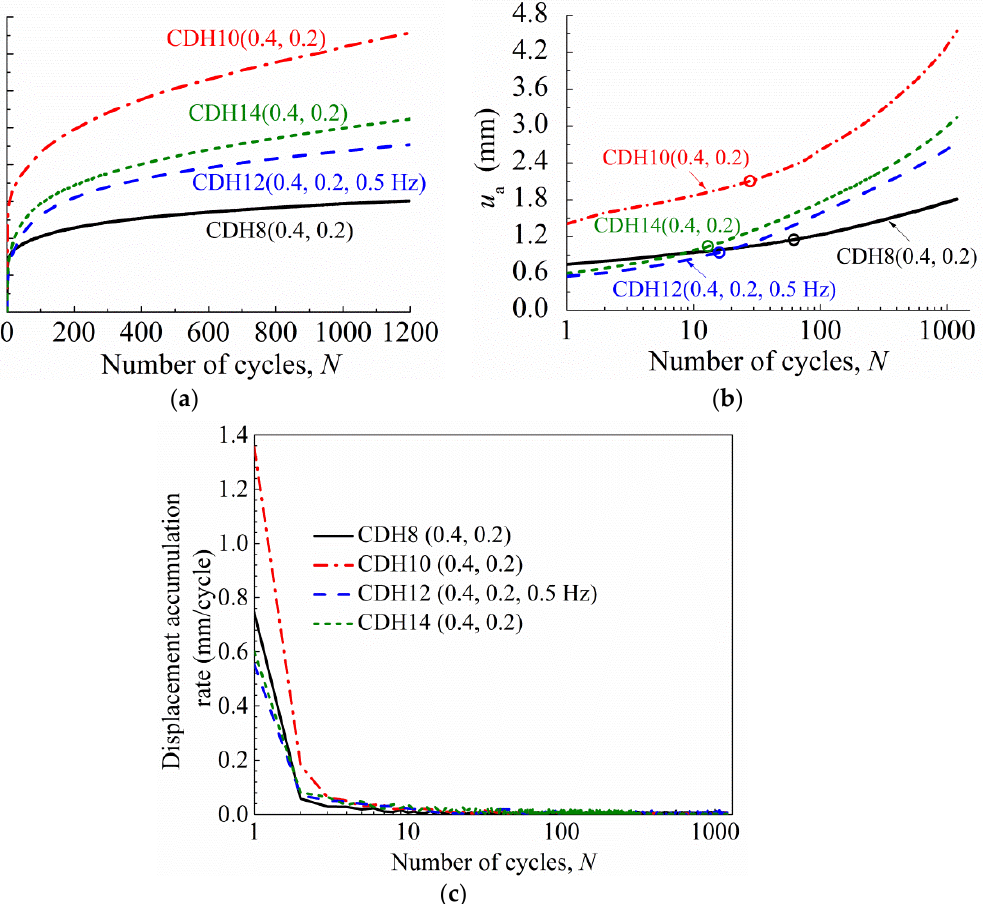
Figure 7. Developments of accumulated displacement and displacement accumulation rate at dif- ferent embedment ratios: ( a ) linear scale of u a - N; ( b ) semi-log scale of u a - N; ( c ) semi-log scale of ferent embedment ratios: ( a ) linear scale of u a - N ; ( b ) semi-log scale of u a - N ; ( c ) semi-log scale of displacement accumulation rate and cycle number. displacement accumulation rate and cycle